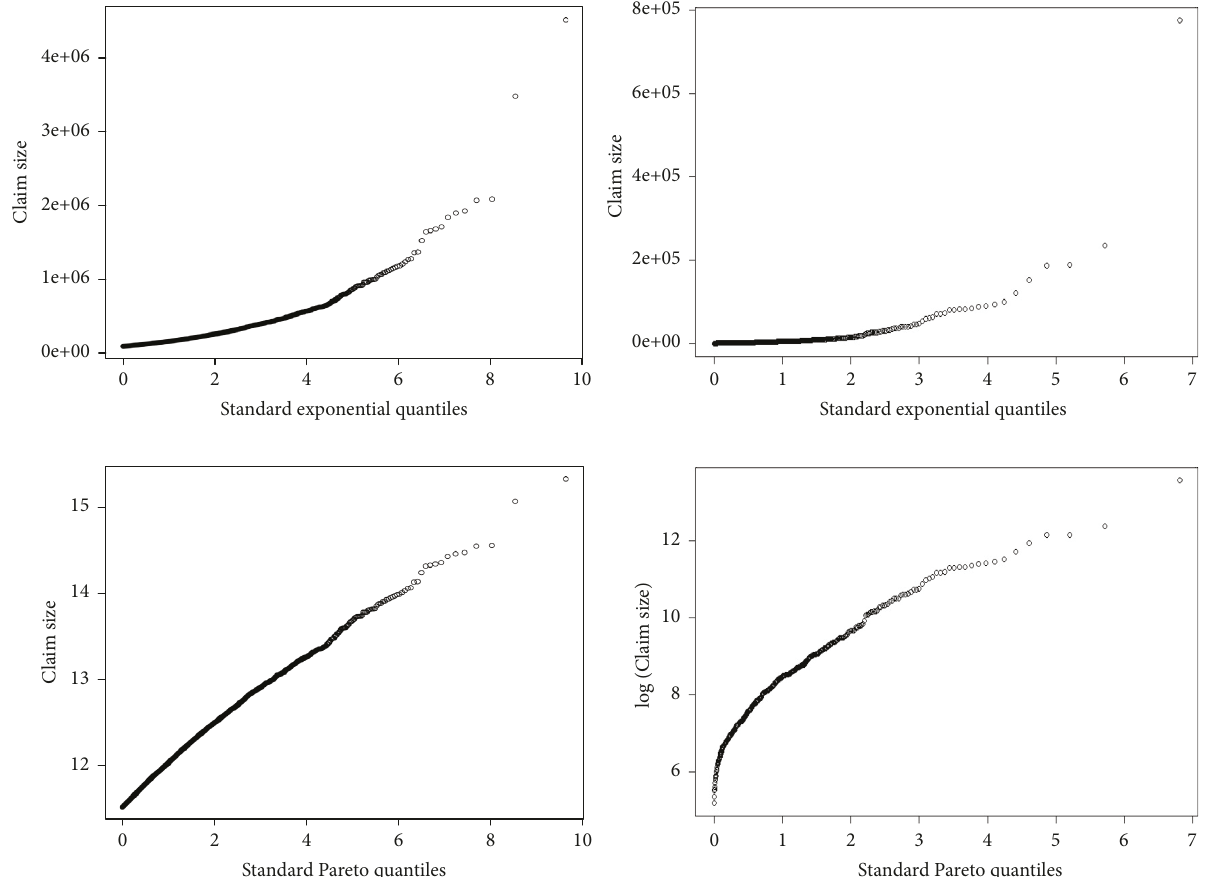
Figure 8: Exponential and Pareto Q-Q plots: SOA claims (left panel); GH claims (right